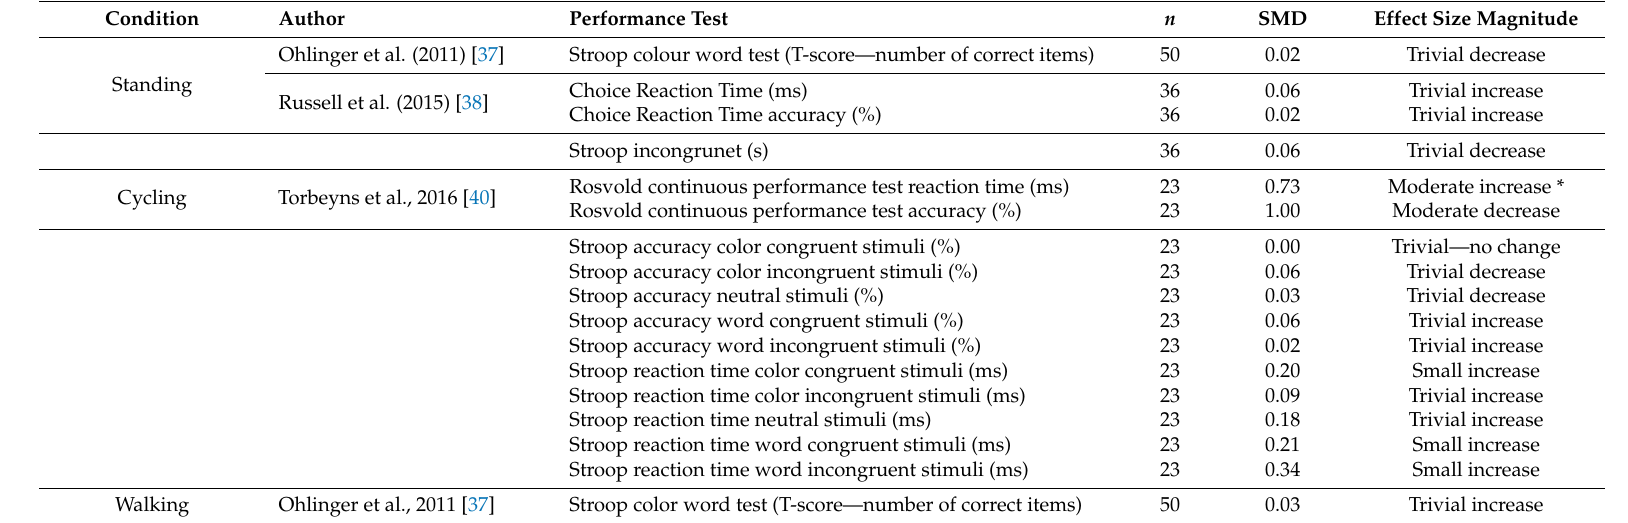
Table 3. Effect of active workstation use on attention.